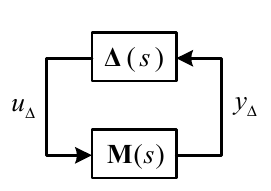
Figure 6. DSP structure with multiplicative output uncertainty.